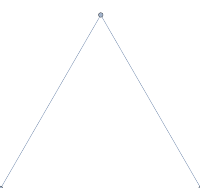
Figure 1. Graph defining the matrix in equation